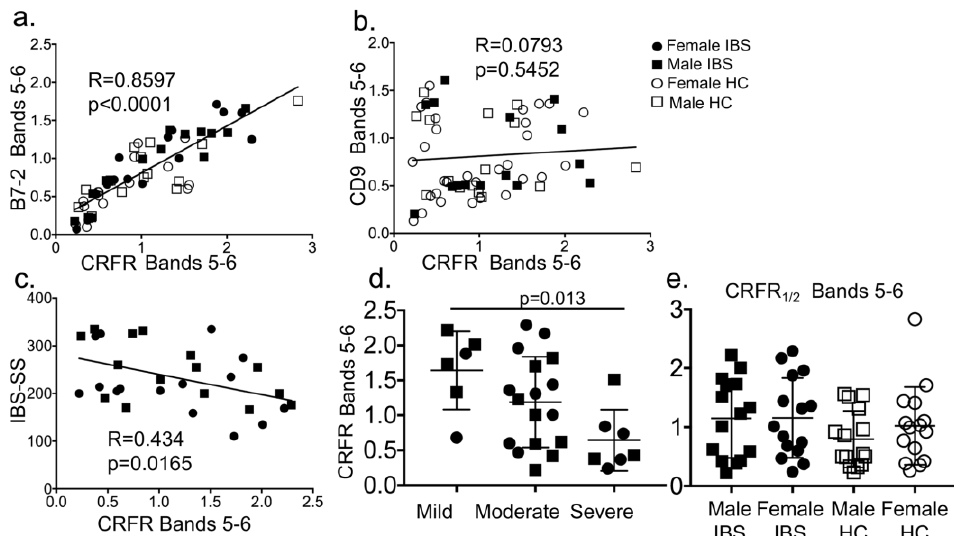
Figure 3. CRF receptor levels show a strong positive association with B7-2+ EVs and a negative relationship with IBS scores. ( a ) Linear regression analysis showed a strong positive correlation (R = 0.859, p < 0.0001) between B7-2 and CRFR expression in plasma from IBS-D patients and HC (n = 15/sex/group). ( b ) No correlation was seen between CD9 and CRFR expression in plasma from IBS-D patients and HC (n = 15/sex/group). ( c ) A negative correlation between IBS severity score (IBS-SS) and CRFR expression (R = 0434, p = 0.0165) was seen (n = 30 IBS patients). ( d ) CRFR expression decreased in accordance with disease severity of IBS (mild: 1.64 ± 0.56 vs. severe: 0.64 ± 0.44, p = 0.013). Statistical analysis: Tukey’s multiple comparisons test. ( e ) CRFR expression was quantified from immunoblot and Two-way ANOVA showed no significant main effect of disease (IBS vs. HC), or sex (n = 15/sex/group).